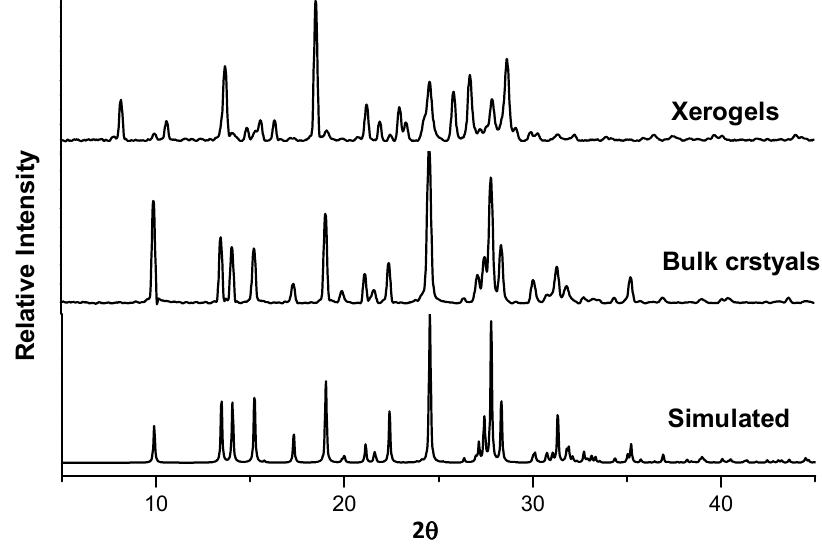
Figure 6. X-ray powder diffraction (XRPD) comparison of diNO : simulated pattern from single-crystal X-ray diffraction (SCXRD) data, bulk crystals, and xerogel obtained from water.